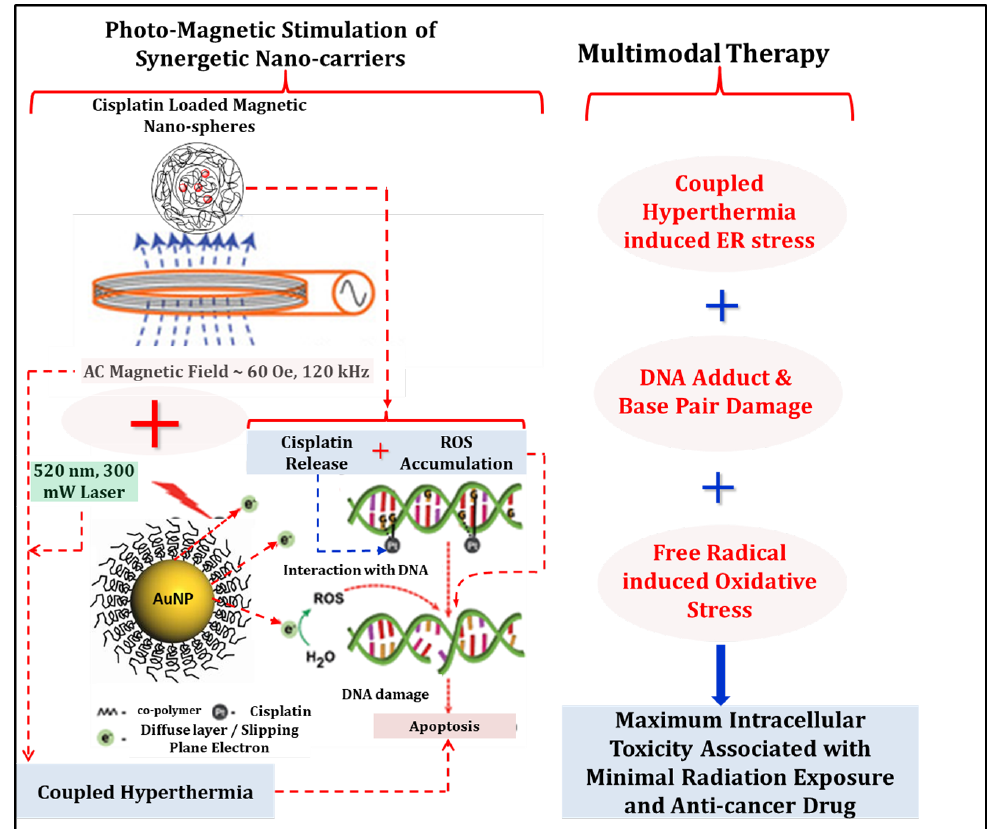
Figure 7. Photo-magnetic irradiation mediated multimodal therapeutic strategy of neuroblastoma cells using clusters of nanostructures: coupled hyperthermia, DNA damage, and reactive oxygen species (ROS) -induced apoptosis of B35 neuroblastoma cells in culture. Note that in this experiment, cisplatin has been loaded in a separate non-magnetic nanocarrier.